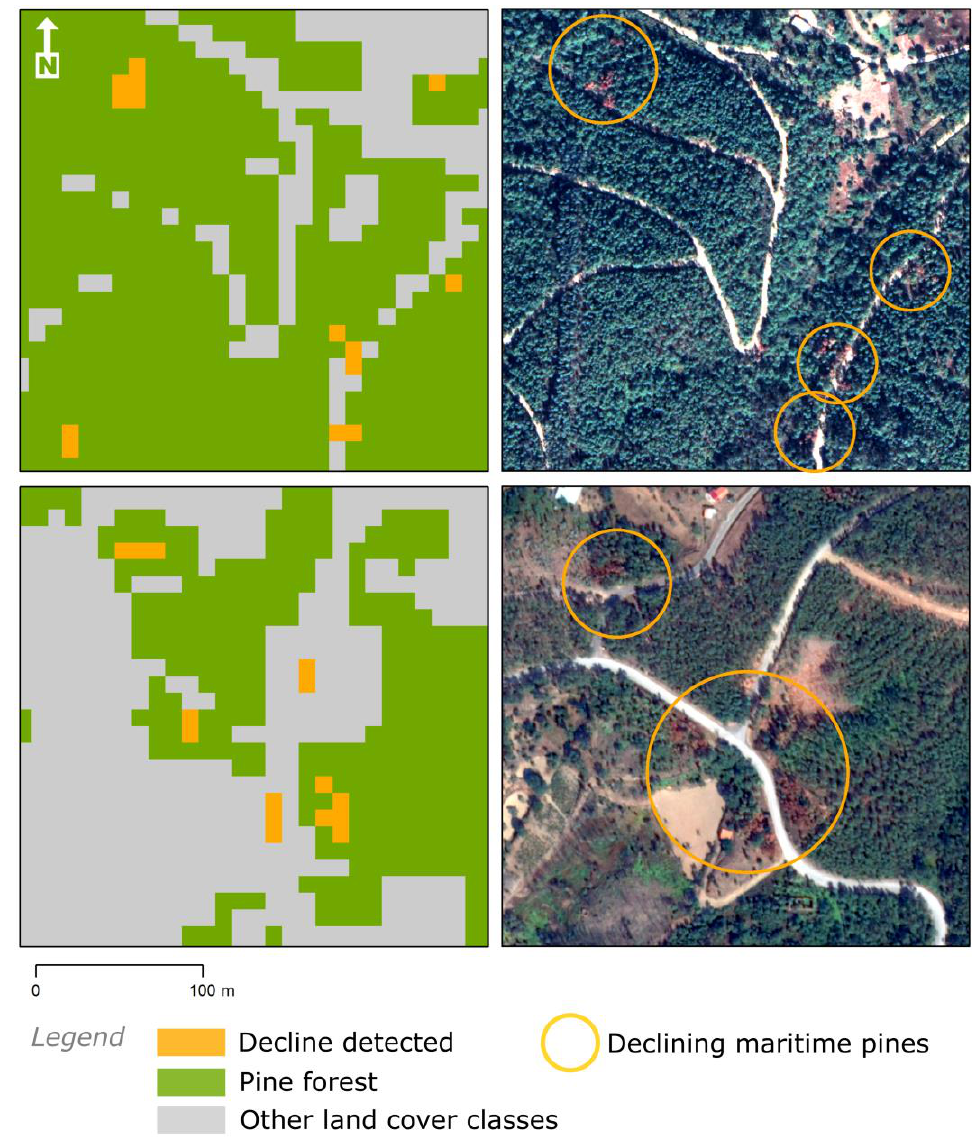
Figure 8. ( Left ): Output of the decline model applied to Sentinel-2 imagery (at the end of the 2018 decline season) and ( Right ): comparison with WorldView-3 True Color RGB. The location of declining trees can be detected visually in the high-resolution imagery (orange circles) and compared against the Sentinel-2-based detections.